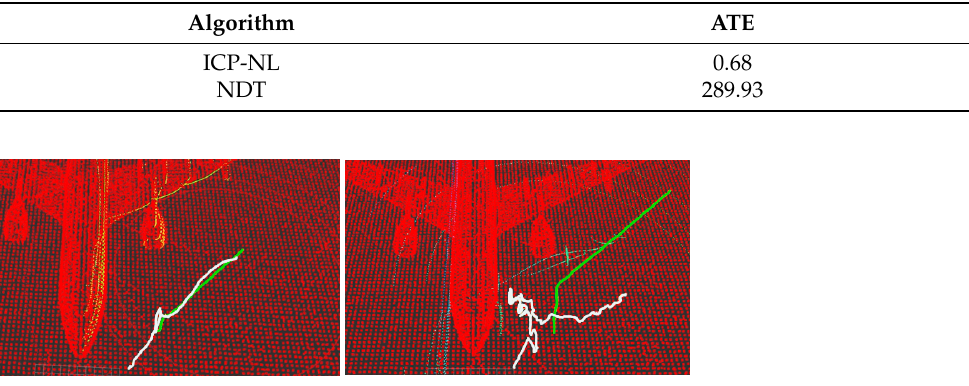
Figure 23. Aircraft 3D map generated by graph SLAM. Table 7. Errors obtained in NDT and ICP-NL simulation tests.